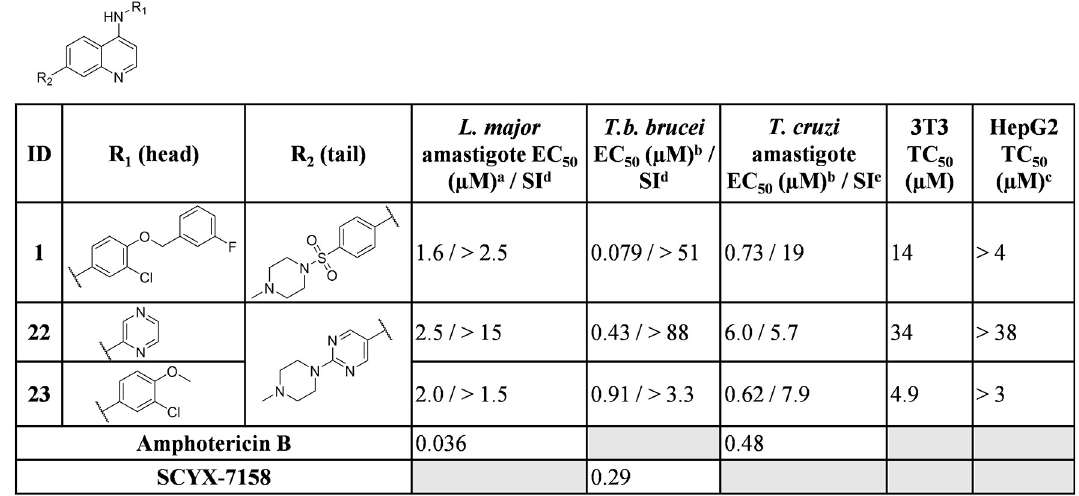
Fig 4. Biological activity of key compounds that combine head (R 1 ) and tail (R 2 ) groups against L . major amastigote, T . b . brucei , T . cruzi cultures and HepG2 human cells. Data for the full screening set is summarized in the supplementary information. nd = not determined a All r 2 values are > 0.9 unless noted otherwise b All SEM values within 25% except for 1 where EC 50 T . cruzi 0.73 (SEM: 0.2; 27%) c Tested concentration ranges were determined based on compound solubility d Selectivity index (SI) calculated relative to HepG2 cells. e Selectivity index (SI) calculated relative to 3T3 cells.